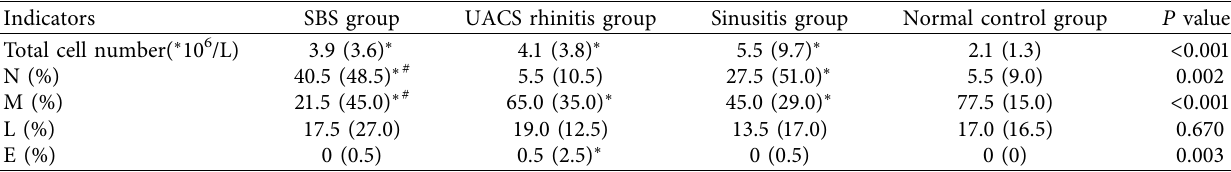
Table 2: Classification of induced sputum cells in each group.